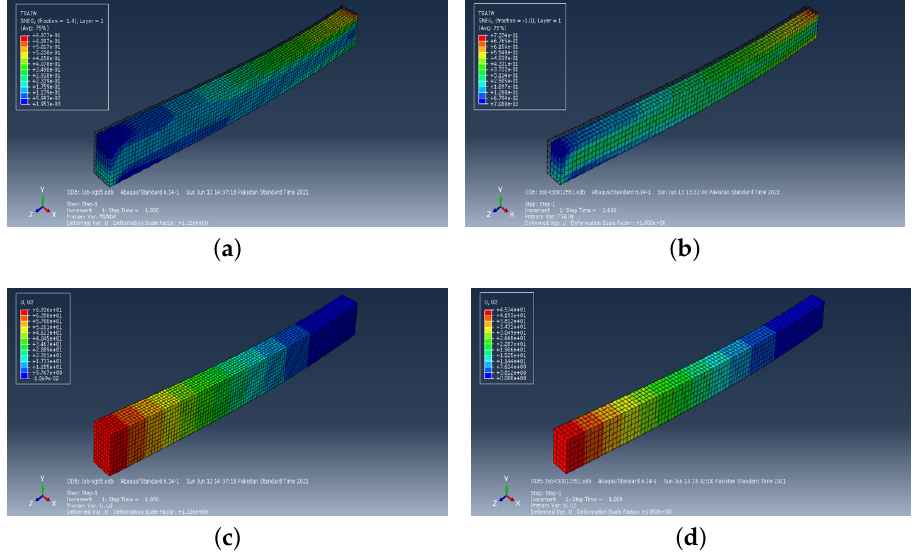
Figure 5. Results of Tsai-Wu failure criterion and deflection of thick laminated composite beams. ( a ) Tsai-Wu failure criterion of S-glass fiber/epoxy laminated beam (65 plies). ( b ) Tsai-Wu failure criterion of T300 carbon fiber/epoxy laminated beam (51 plies). ( c ) Deflection of S-glass fiber/epoxy laminated beam (65 plies). ( d ) Deflection of T300 carbon fiber/epoxy laminated beam (51 plies).